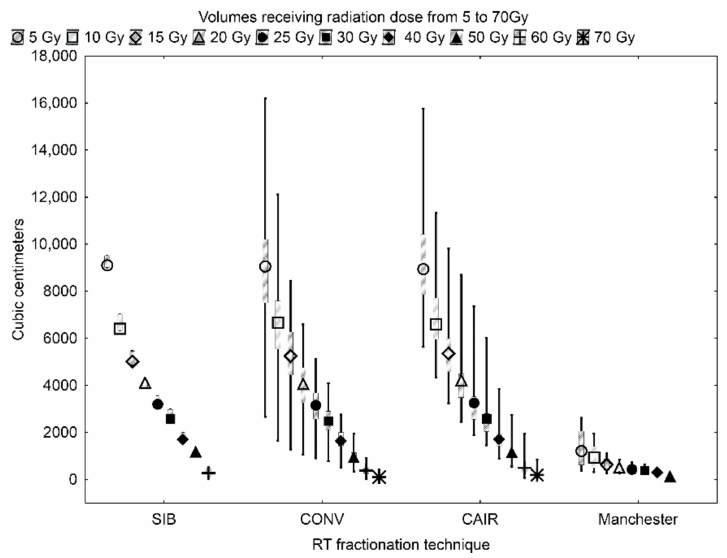
Figure 1. The box and whisker plot comparison of the volumes (in cm 3 ) receiving a particular radiation dose: from 5 to 70 Gy in SIB, CONV and CAIR fractionated radiotherapy (RT); and from 5 to 50 Gy in Manchester fractionated